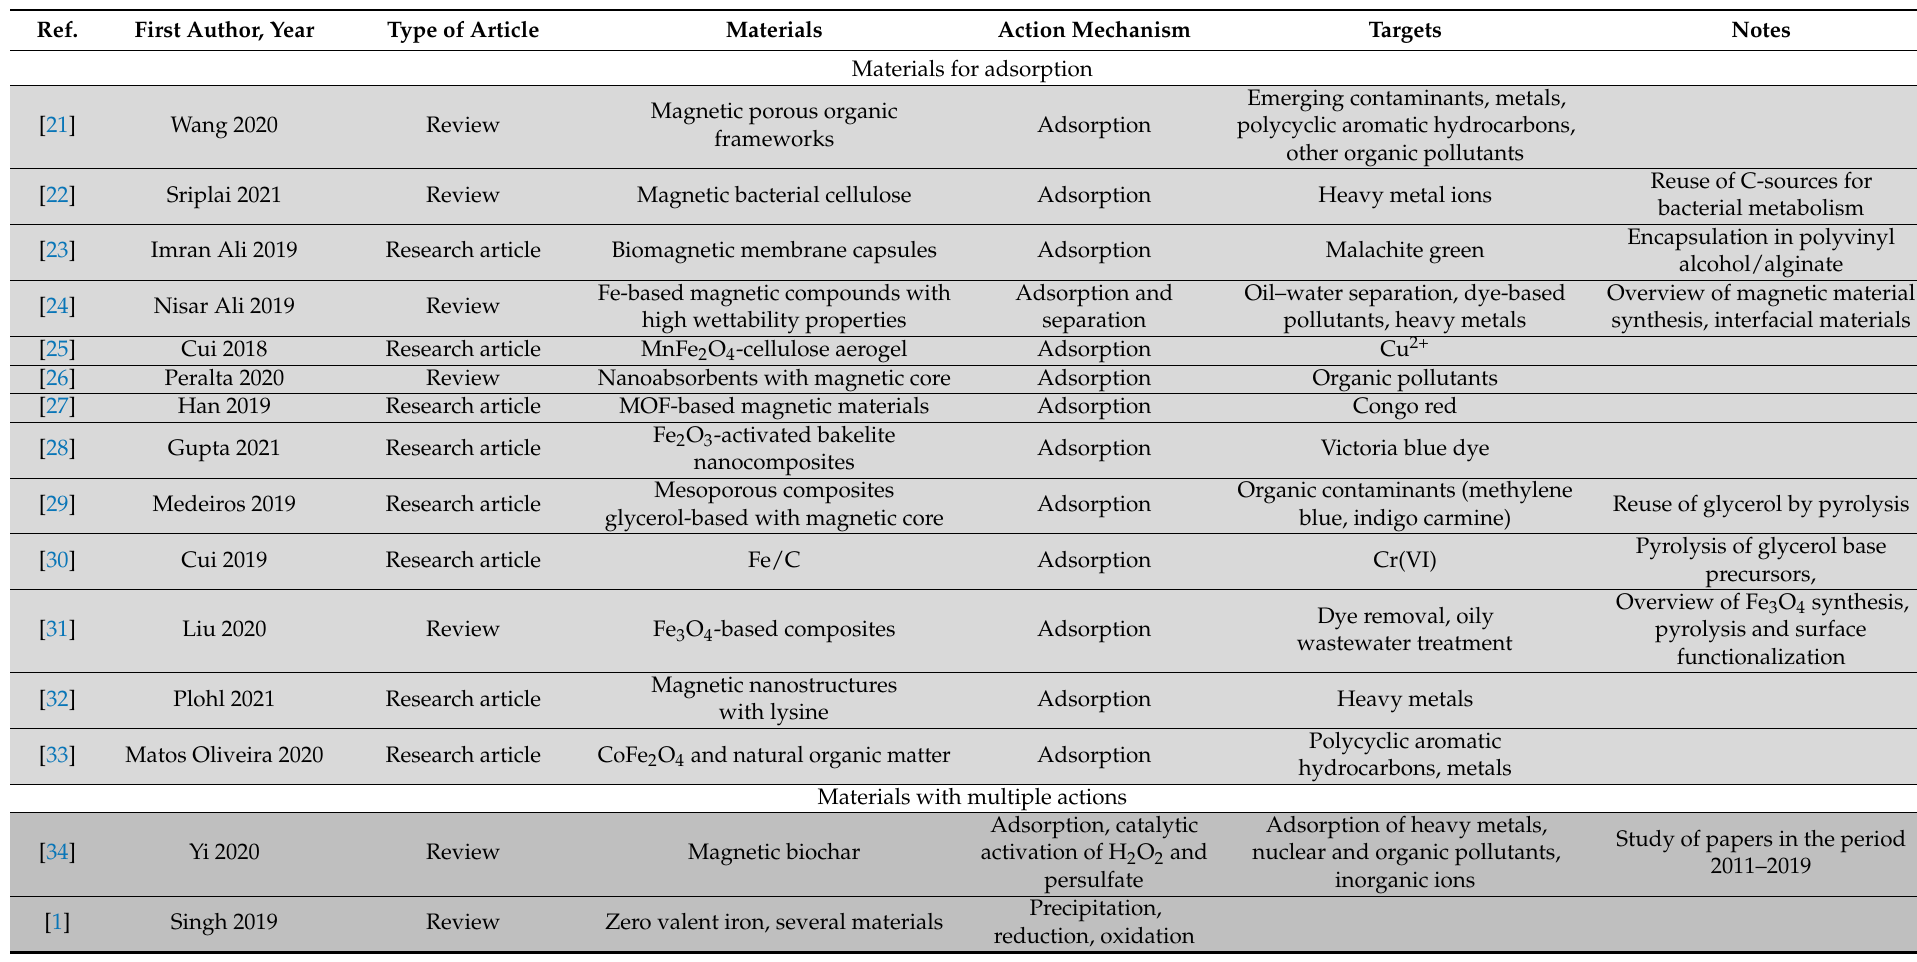
Table 1. Selection of literature papers and reviews concerning the use of magnetic materials in environmental applications (The table colors divide the materials on the basis of their action mechanism against target